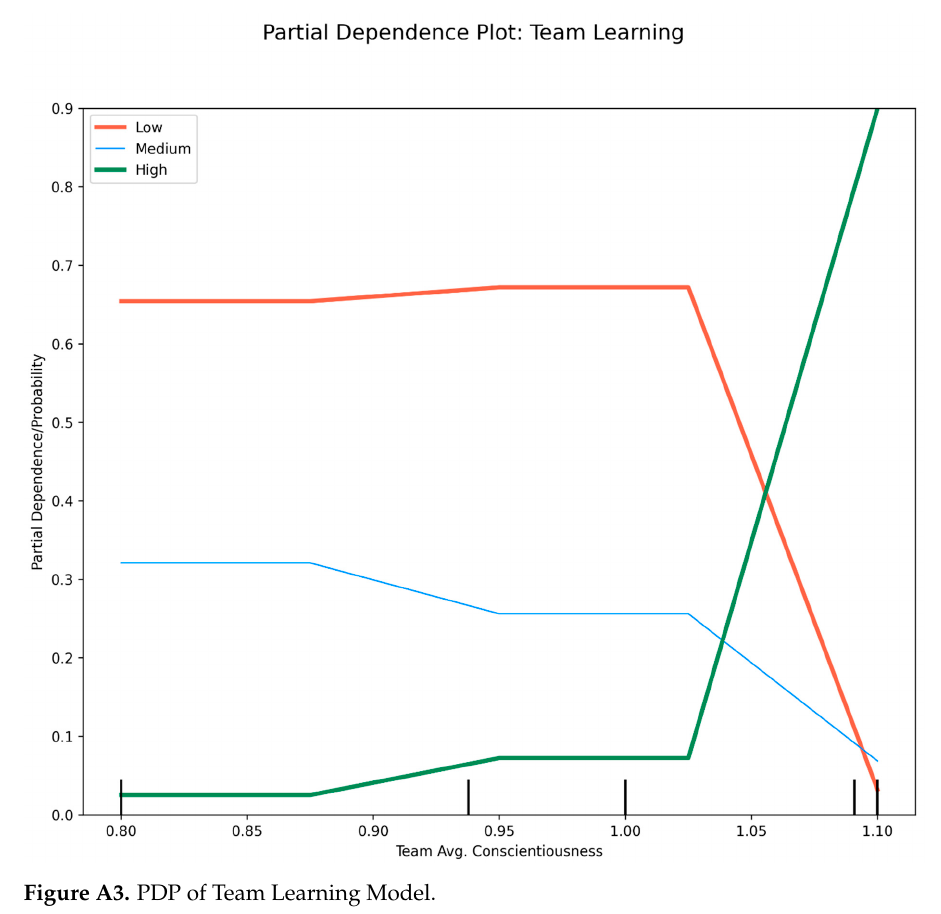
Figure A3. PDP of Team Learning Model.